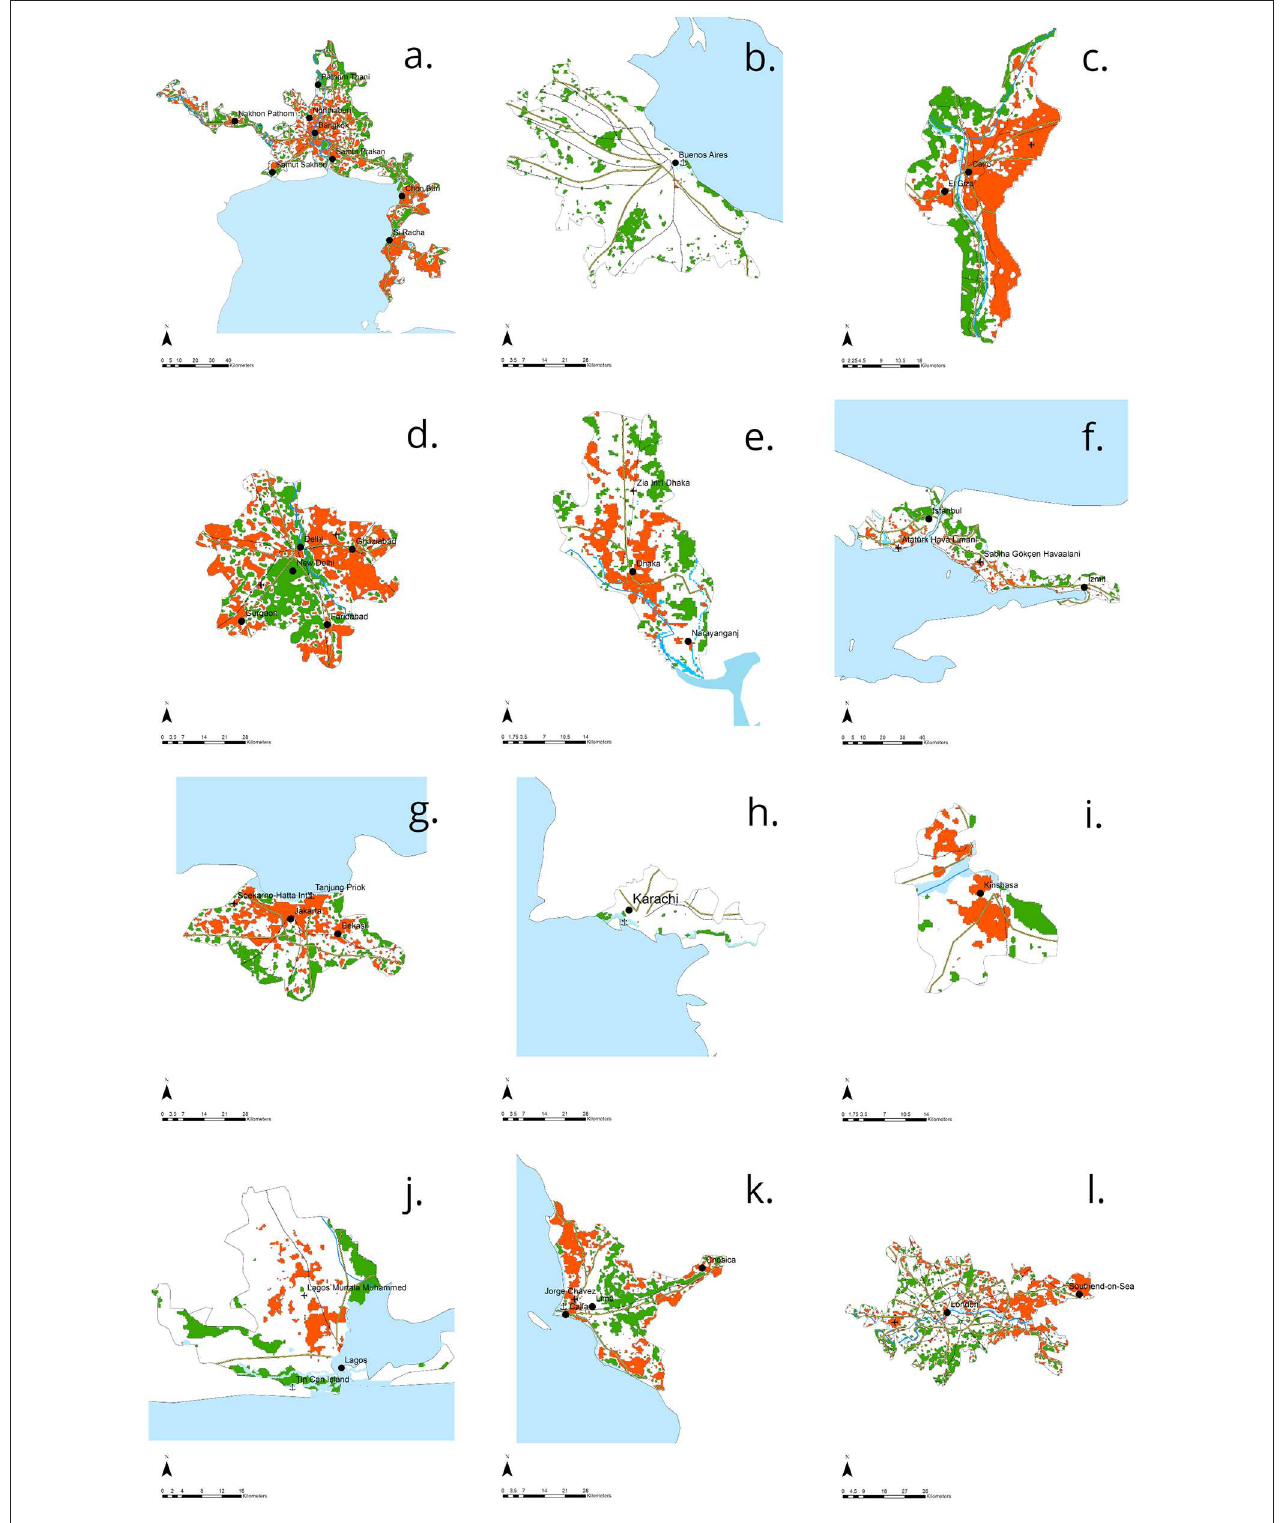
FIGURE 3A | The hot spot (green) and cold spot (red) clusters, city centers (dots), waters (blue), expressways (yellow lines), railways (black hashed lines), marine ports (anchors), airports (airplanes) within the metropolitan areas of: (a) Bangkok, (b) Buenos Aires, (c) Cairo, (d) Delhi, (e) Dhaka, (f) Istanbul, (g) Jakarta, (h) Karachi, (i) Kinshasa, (j) Lagos, (k) Lima, (l)